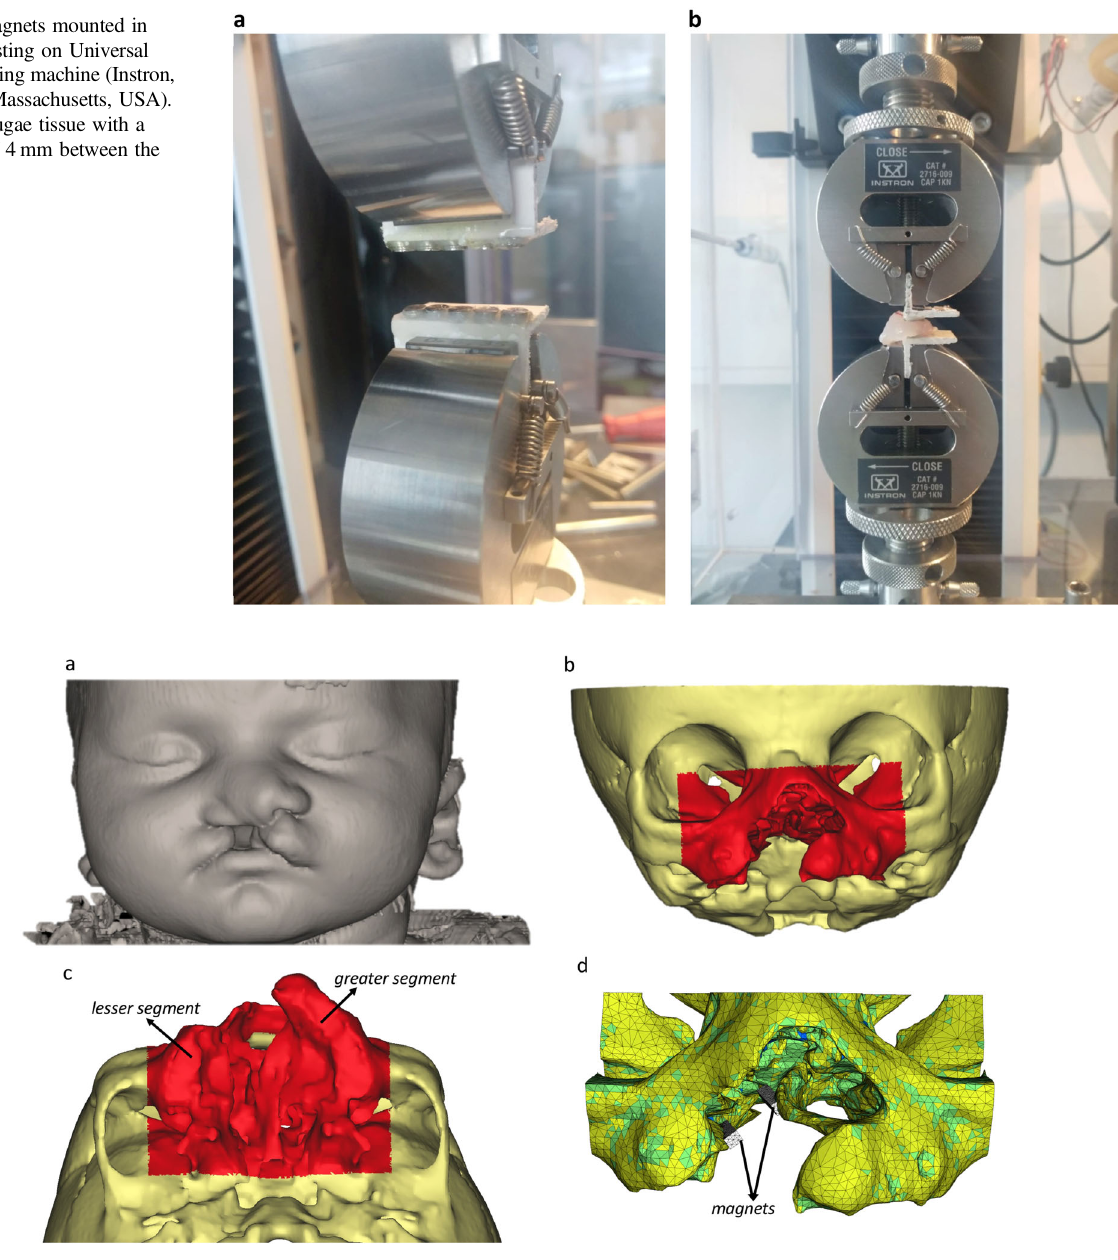
Fig. 1 a Magnets mounted in strips for testing on Universal material testing machine (Instron, Norwood, Massachusetts, USA). b Porcine rugae tissue with a thickness of 4 mm between the magnets